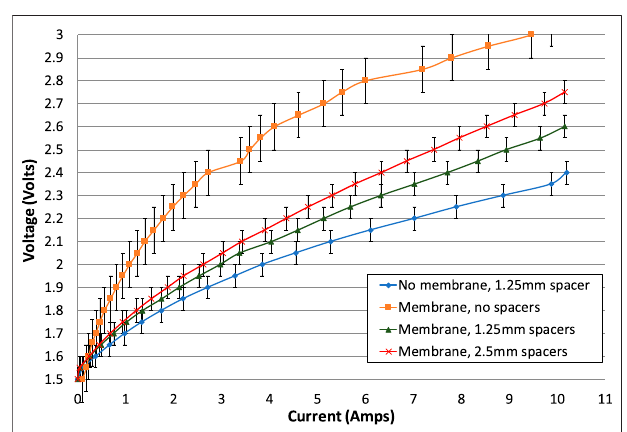
FIGURE6| Electrolysistestsforallcellcon fi gurationsofphase1testing. The increasing and decreasing portions of the electrolysis tests have been averaged. With the exception of the test of a membrane with no spacers, the second electrolysis test is shown. Error bars added indicate variation in test repeatability.